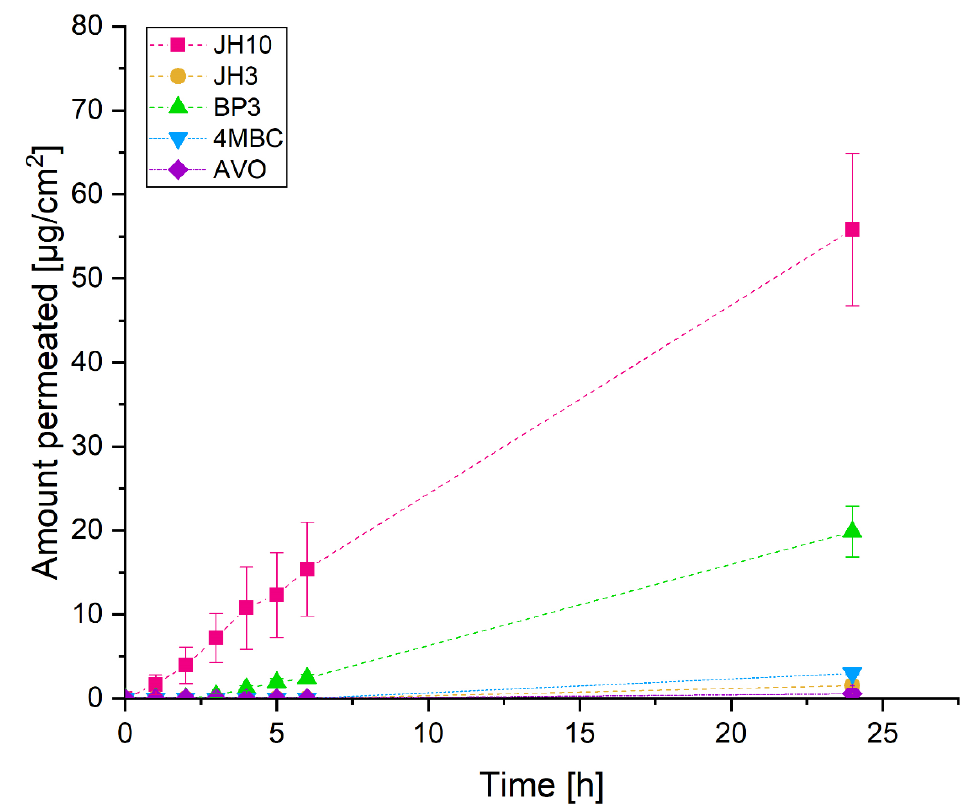
Figure 1. The absorption-time profiles of studied compounds and commercial UV filters incorpo- rated into a formulation (expressed as average percentage ± standard deviation of exposure dose) permeated through Episkin TM following 24 h exposure to 10 mg/cm 2 (finite dose) of the studied com- pounds and commercial UV filters: BP3 — benzophenone-3, 4MBC — 4-methylbenzylidene camphor, AVO — avobenzone. Samples were tested in two independent experiments using three tissues for each chemical.